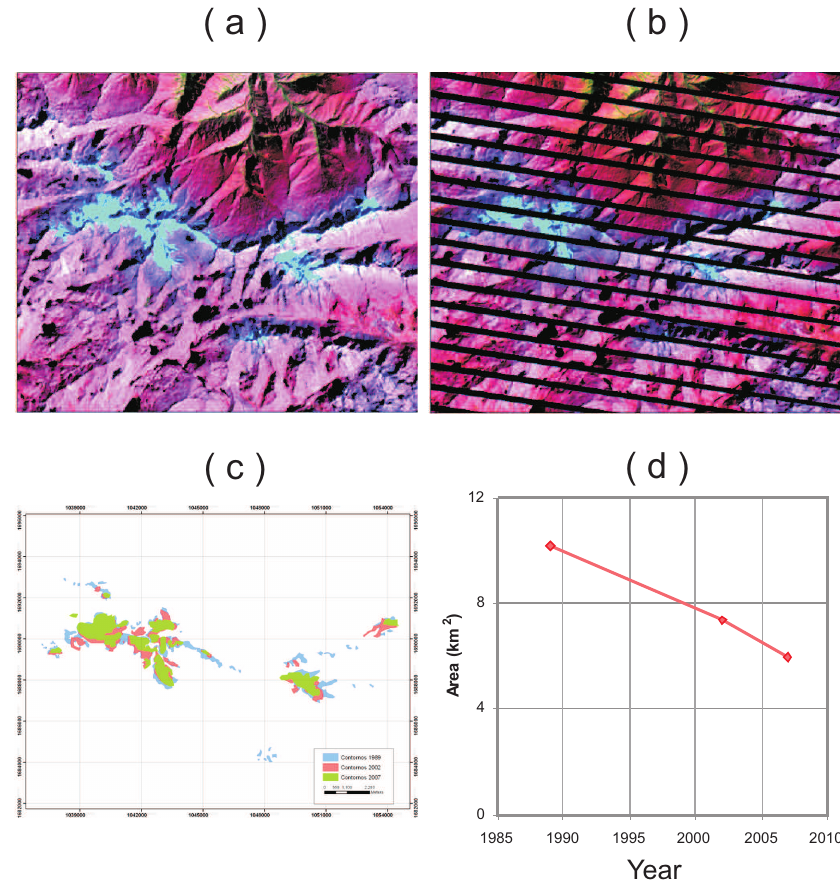
Fig. 5. Landsat images of Sierra Nevada de Santa Marta glacier in (a) December 1989, and (b) January 2007. (c) Glacier countours in 1989 (blue), 2002 (pink), and 2007 (green). (d) Time evolution of glacier areal extent: 10.14 km 2 (1989), 7.33 km 2 (2002), and 5.95 km 2 (2007).